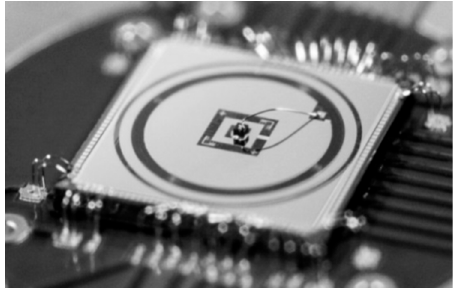
Figure 15. Opto-ASIC mounted onto PCB with assembled laser diode on the additional metal top layer, in comparison to Figure 12.